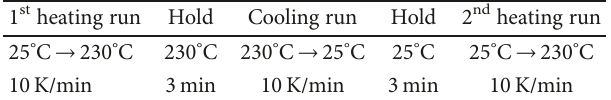
Table 4: Temperature pro fi le used for the DSC